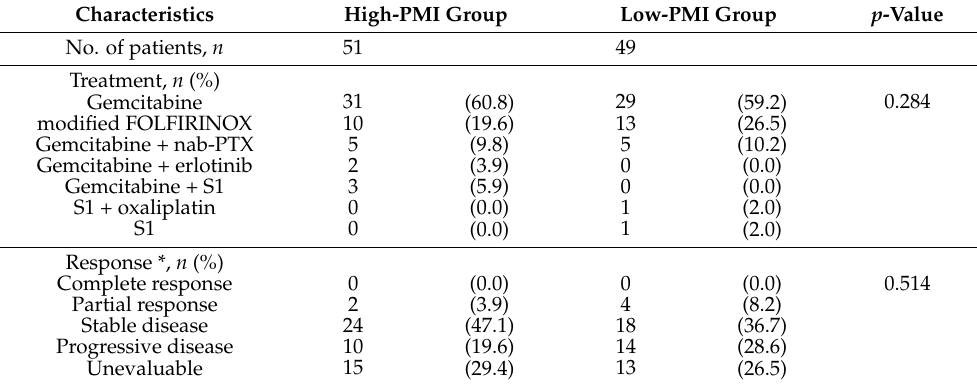
Table 2. Comparison of the clinical outcomes between the high- and low-PMI